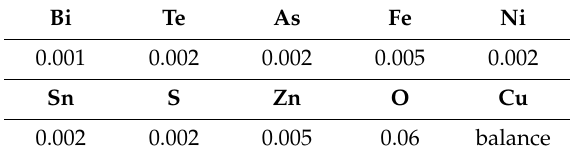
Table 1. Chemical composition of copper wire (not more than, wt %) [24].